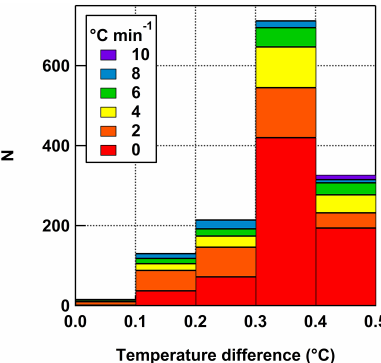
Figure 4. Freezing spectra for the control experiments conducted to characterize the DFCP system. Results included here are tests eval- uating the most proficient hydrophobic coating with blank UPW drops. Error bars for the y and x axes correspond to standard devi- ation per 0.5 ◦ C bin and temperature probe–plate versus drop vari- ability standard deviation, respectively. Spectra that do not reach a frozen fraction of 1 indicates not all drops froze at the lower limit of the DFCP. The inset shows an example of the appearance of frozen versus unfrozen 2.5µL drops on the copper disc.